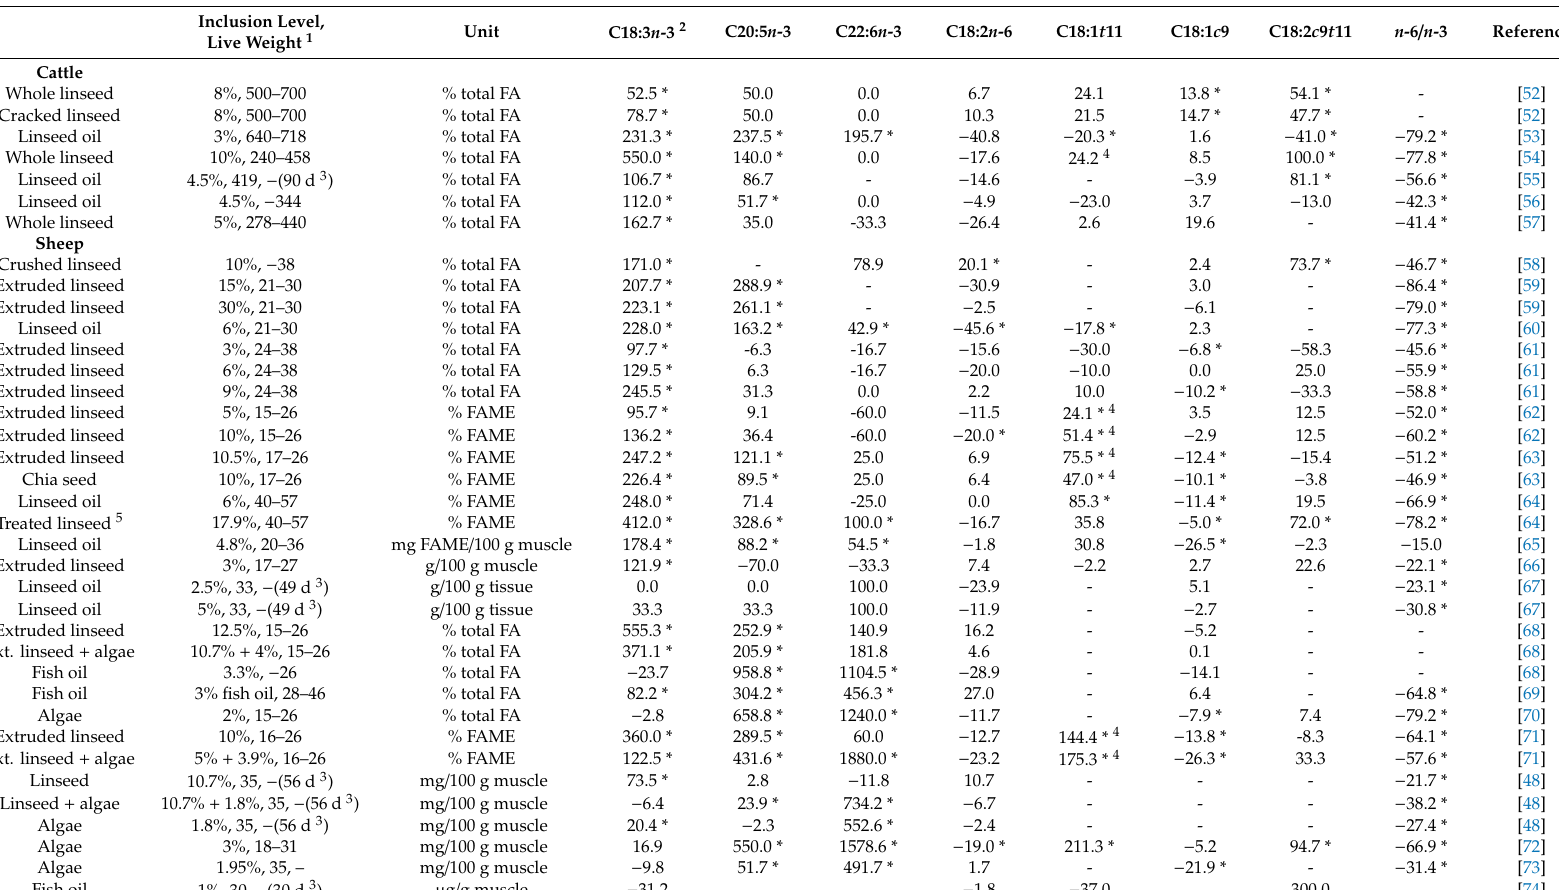
Table 1. Results of di ff erent studies of the e ff ect of dietary inclusion of n -3 long chain polyunsaturated fatty acid (PUFA)-rich sources on the fatty acid composition of intramuscular fat in ruminants. E ff ects are shown as relative variation with respect to the control diet and expressed in